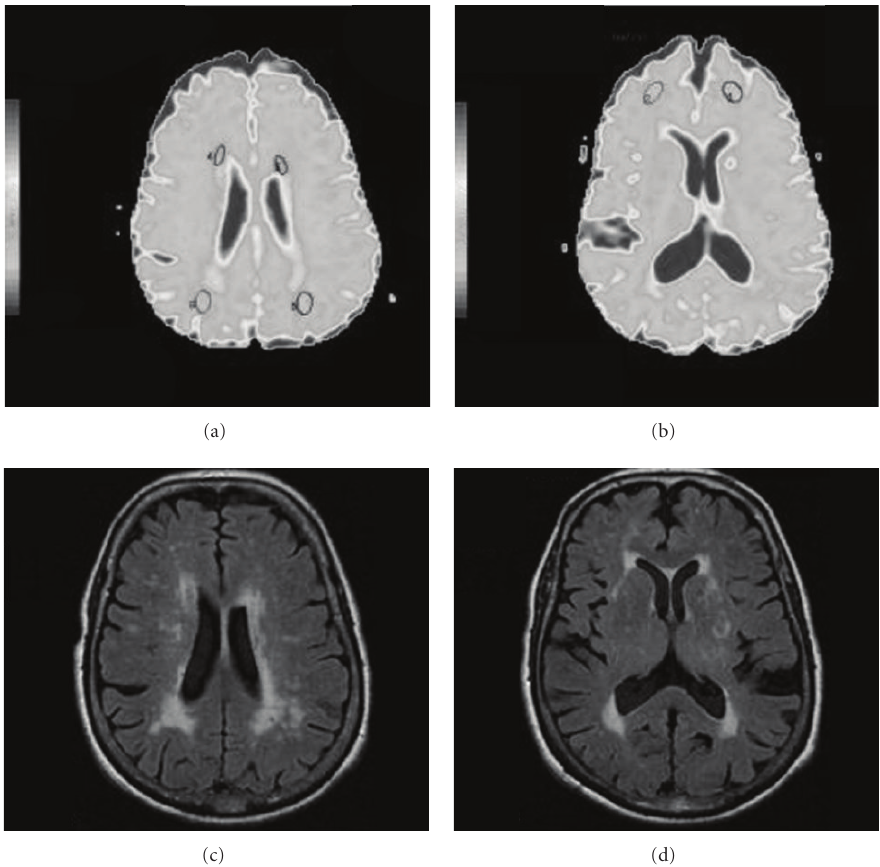
Figure 1: (a) and (b) ADC Map with representation of Regions of interest in Parieto-Occipital Normal Appearing White Matter (NAWM) and lesioned white matter (LWM) (a) and Frontal Normal Appearing White Matter (NAWM) (b). (c) and (d) Corresponding planes in FLAIR